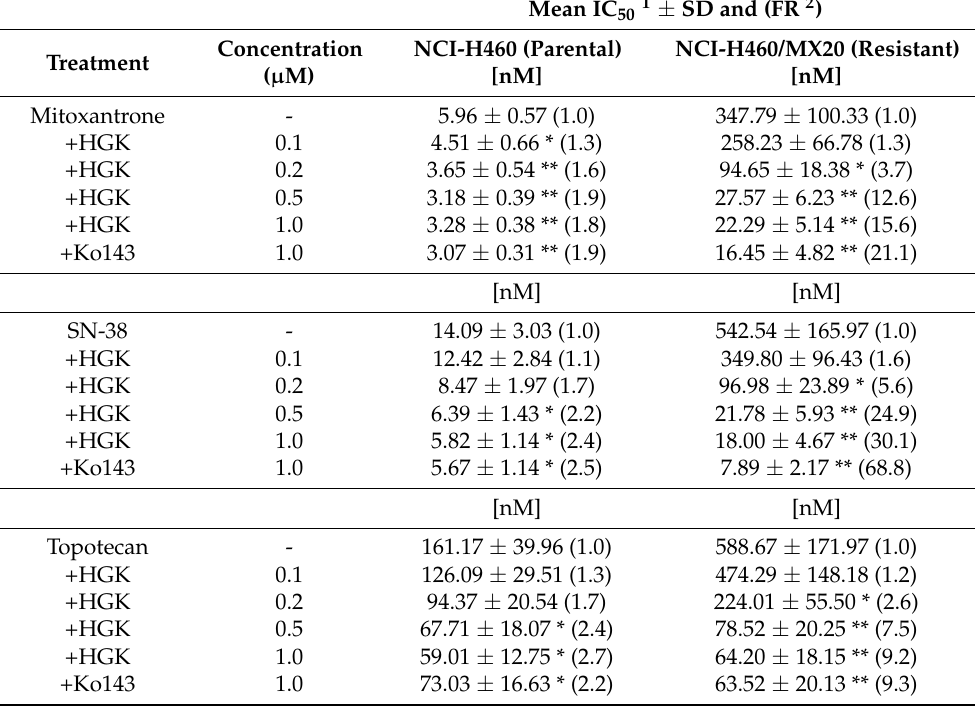
Table 3. The effect of hydroxygenkwanin on reversing ABCG2-mediated multidrug resistance in drug-resistant human cell